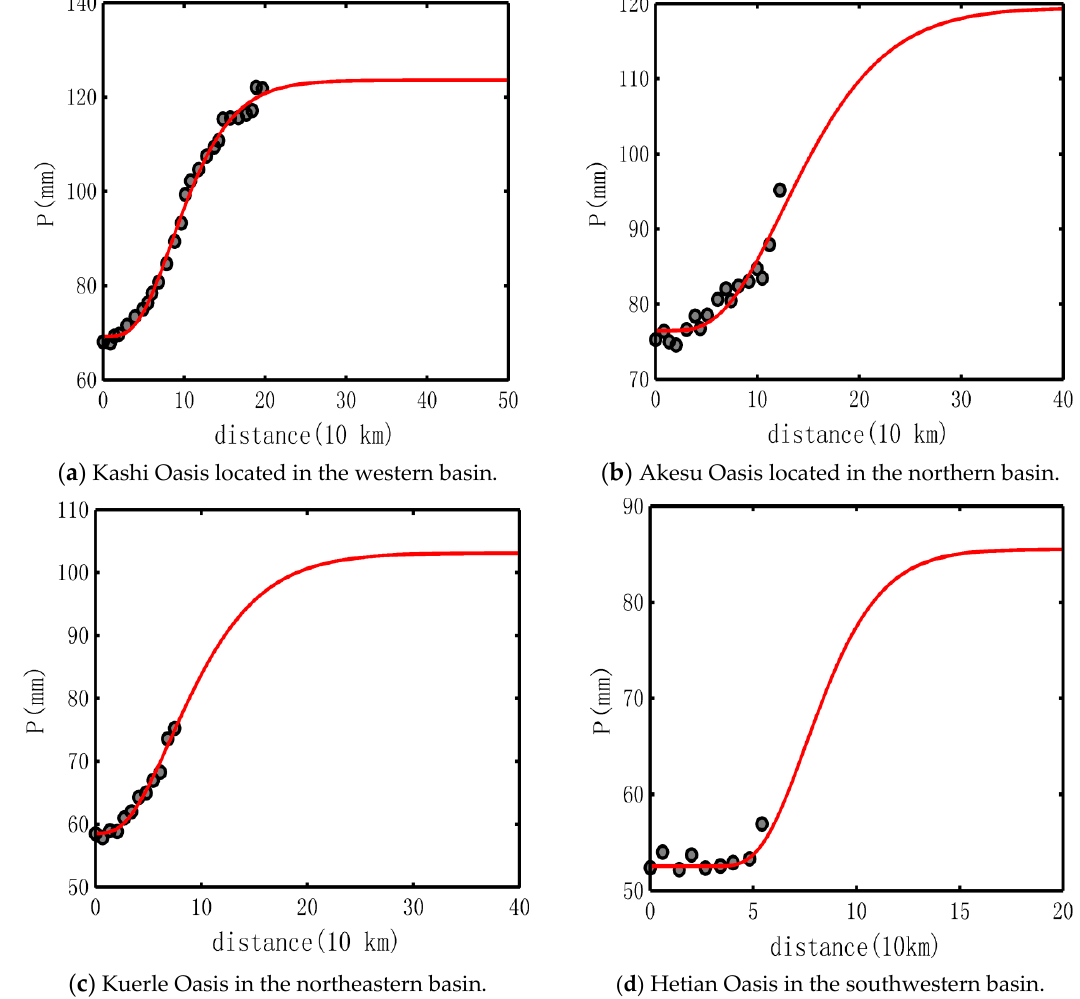
Figure 8 . The simulated precipitation evolution from desert to oasis with the oasis width